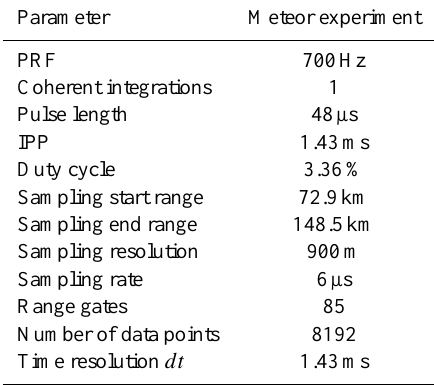
Table 2. MAARSY system parameters used for the meteor head experiment. The abbreviations PRF stands for pulse repetition fre- quency and IPP means inter- pulse